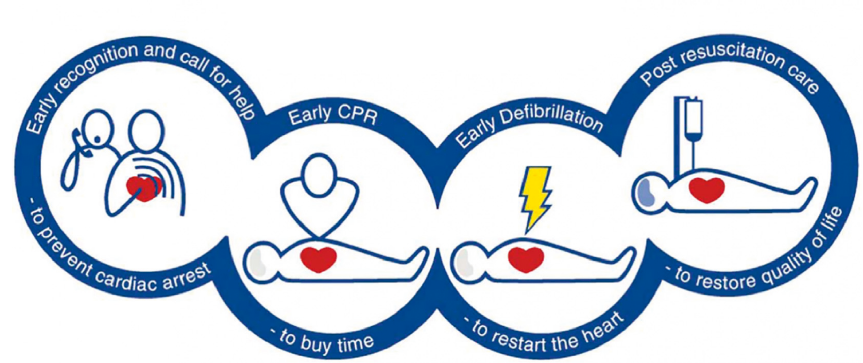
Figure 1: Chain of